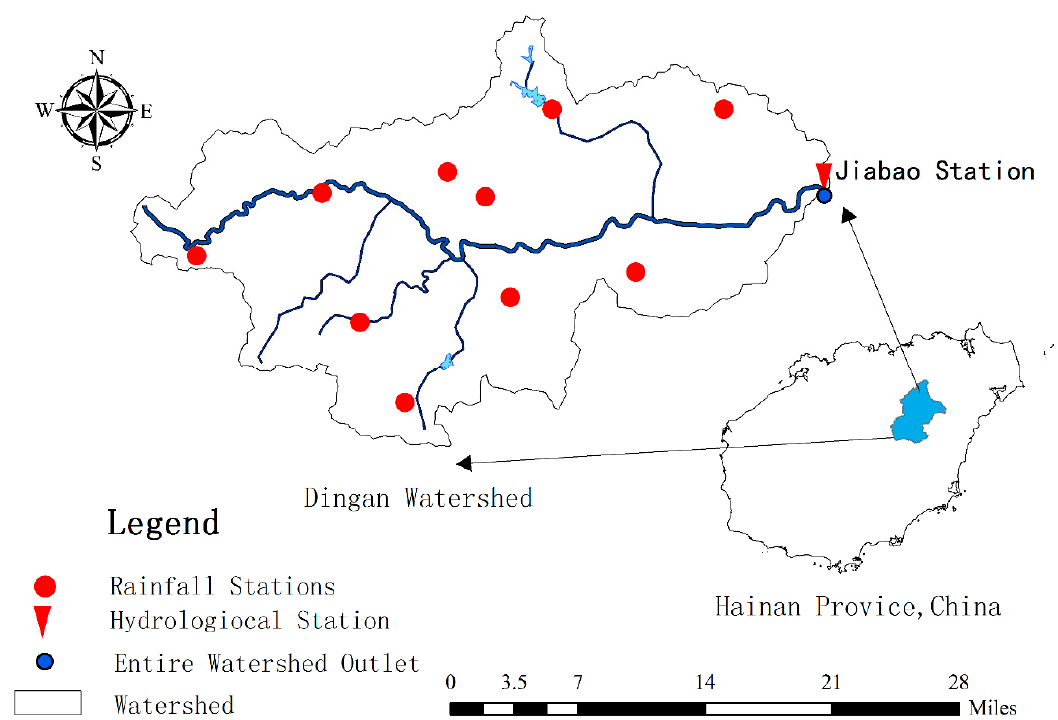
Figure 1. Distribution of hydrological stations network in Dingan River watershed.